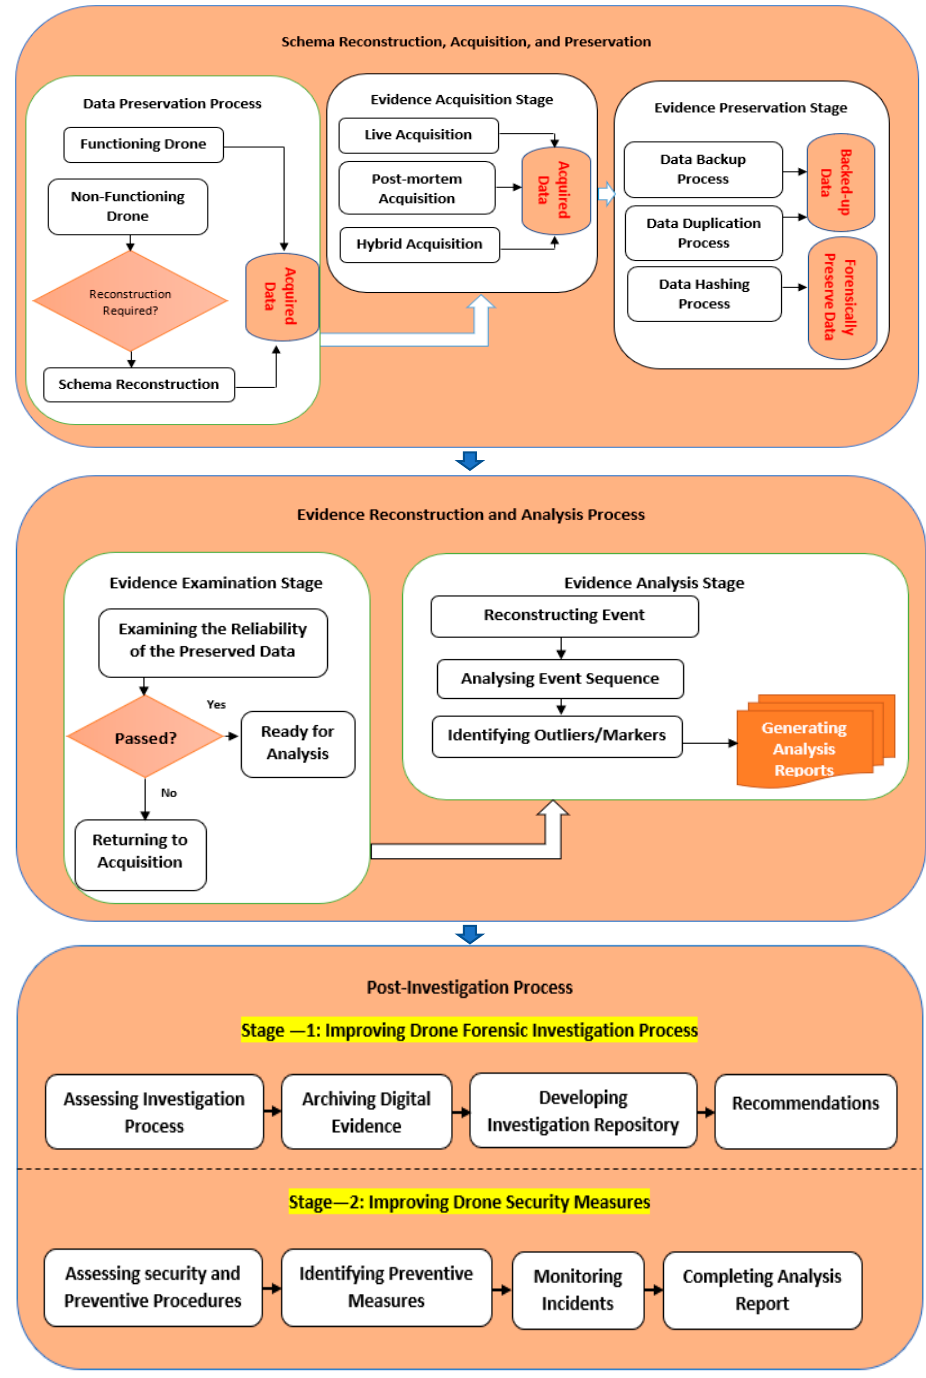
Figure 4. Comprehensive collection and analysis model for the drone forensics